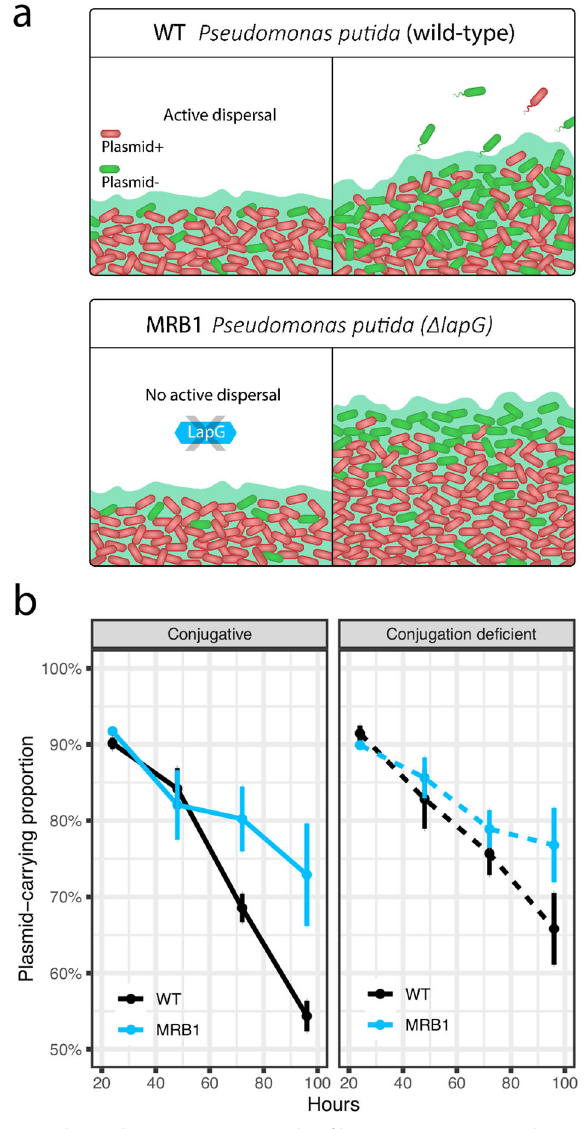
Fig. 1 Plasmid maintenance in bio fi lms over time. a Schematic prediction of plasmid loss in bio fi lm. Dividing cells can lead to segregational plasmid loss-making bio fi lms act as a reserve for plasmids because of the presence of metabolically inactive cells. However, dispersal from the bio fi lm (WT) will in fl uence the stability of the plasmid in the population over time. Here, we used an isogenic mutant MRB1, incapable of bio fi lm dispersal, to examine the in fl uence of bio fi lm dynamics on plasmid maintenance. b Plasmid loss over time in bio fi lms. Plasmid loss in bio fi lm cultures of a dispersing (WT) and non-dispersing (MRB1) variant of P. putida monitored for 4 days. Error bars are standard error of the P = 9.85 × 10 − 16 ) showing a cost to plasmid carriage. No effect of